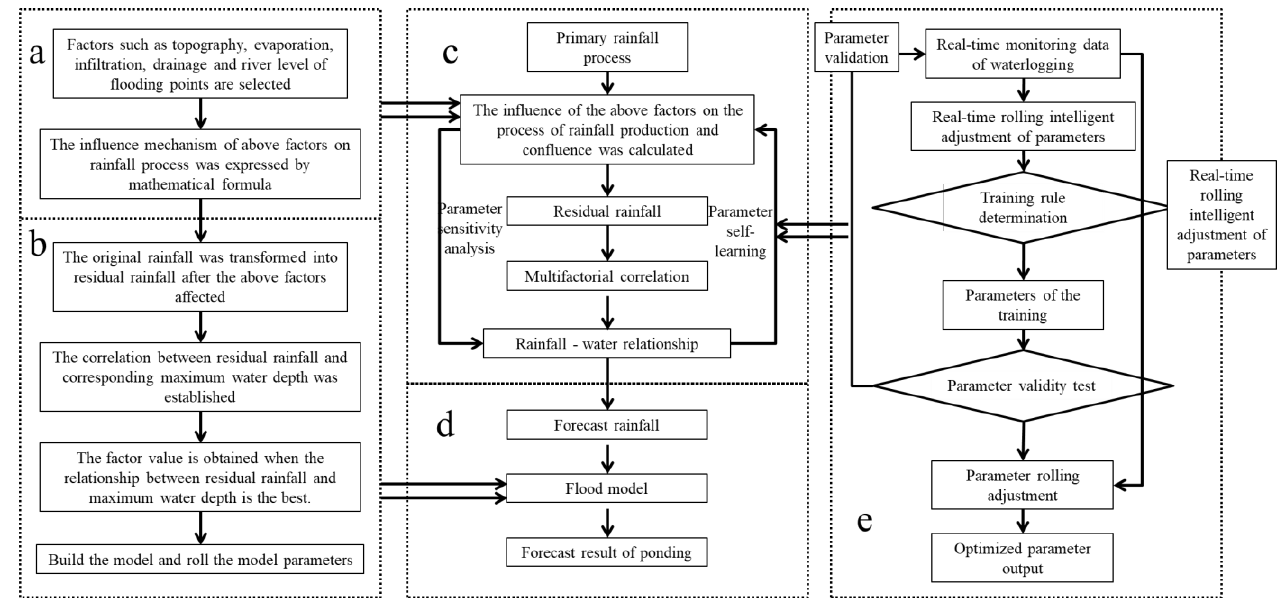
Figure 2. Workflow to obtain factors affecting waterlogging and the influence mechanism ( a ), workflow to build the multi-factor correlation model ( b ), workflow to obtain residual rainfall and rainfall-water relationship ( c ), workflow to forecast waterlogging ( d ), and workflow to optimize model parameters ( e ).